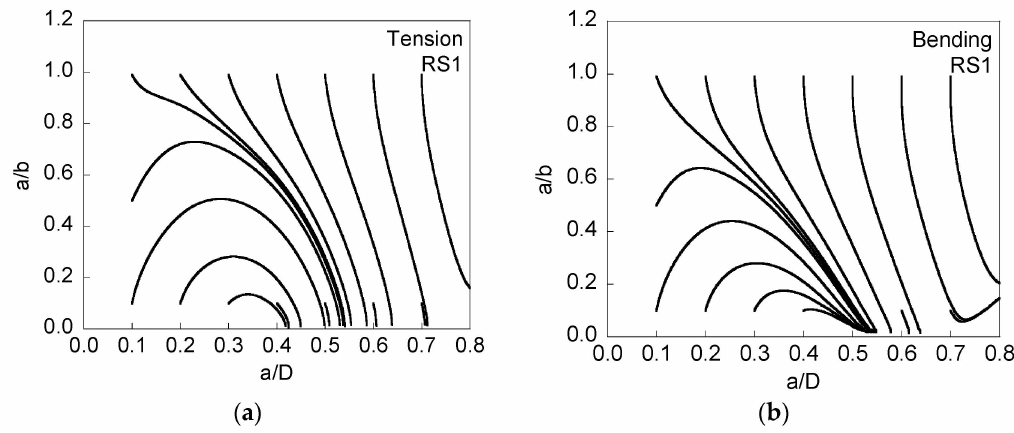
Figure 4. Evolution of the aspect ratio a / b with crack growth (represented by the relative crack depth a / D ) for RS1, cyclic tension loading ( a ); and cyclic bending moment ( b ).